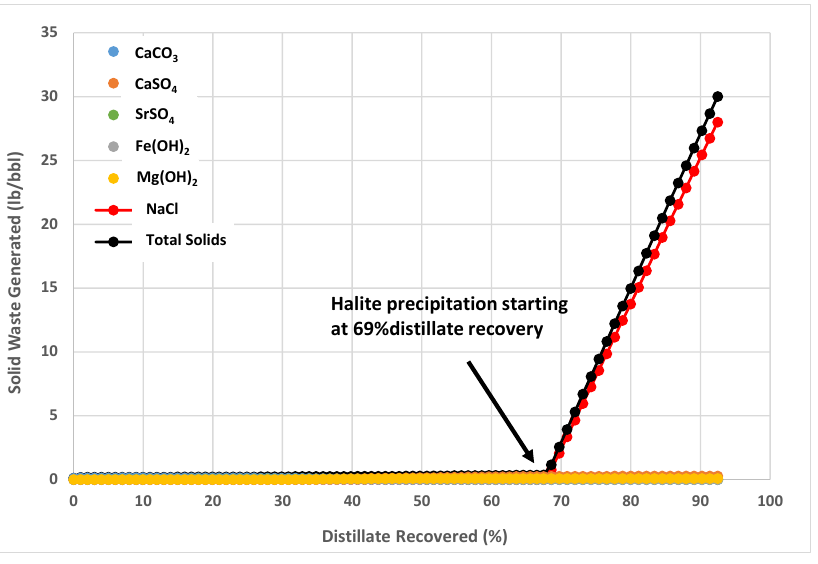
Figure 1. Solids production as a function of distillate recovered during desalination of PW.